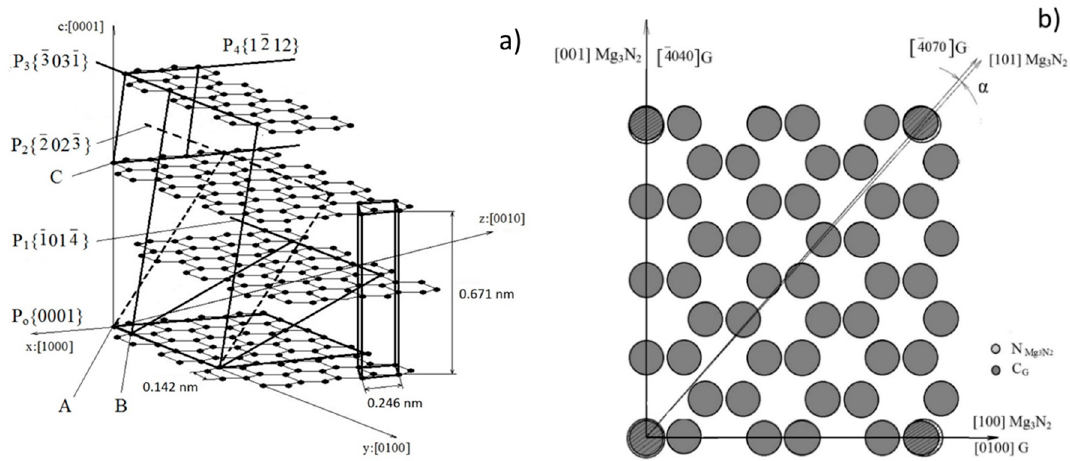
Figure 18. Crystallography details for disregistry calculation: ( a ) Spatial geometry of the crystallographic lattice of graphite; ( b ) correlation between the crystallographic structure of graphite in the plane P 0 {0001} and Mg 3 N 2 , reproduced from [104] with permission from Springer.